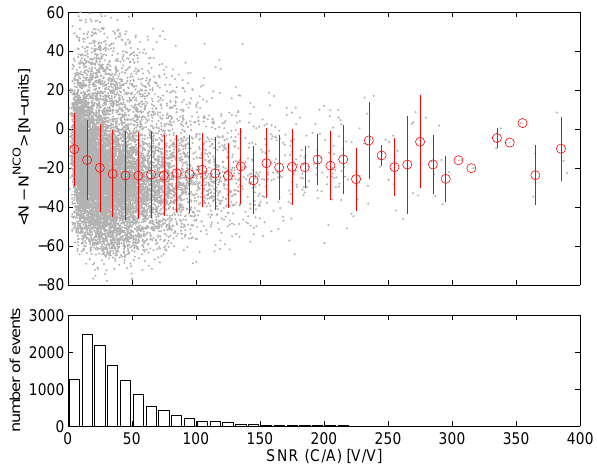
Fig. 9. Top: difference between the refractivities N and N NCO , averaged between 0 and 3 km altitude, as a function of C/A code SNR (grey dots). Red circles mark the mean values in SNR bins spaced 10 V/V, vertical lines indicated the 1- (cid:27) standard deviation. The analysis is based on the complete data set obtained during the time period 24 July to 17 November 2008. Bottom: number of occultation events within the individual SNR bins. (For details see text.)